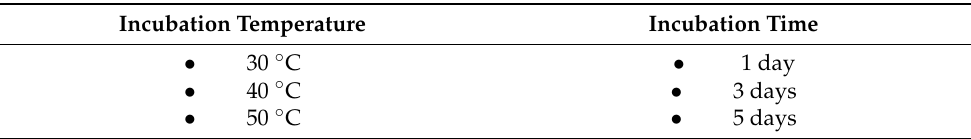
Table 2. Enzymatic incubation